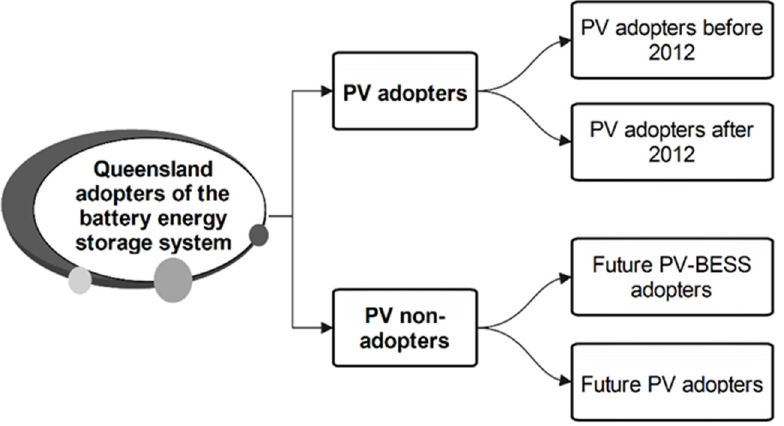
Figure 4. The proposed categorisation of BESS and PV–BESS adopters for Queensland dwellings.